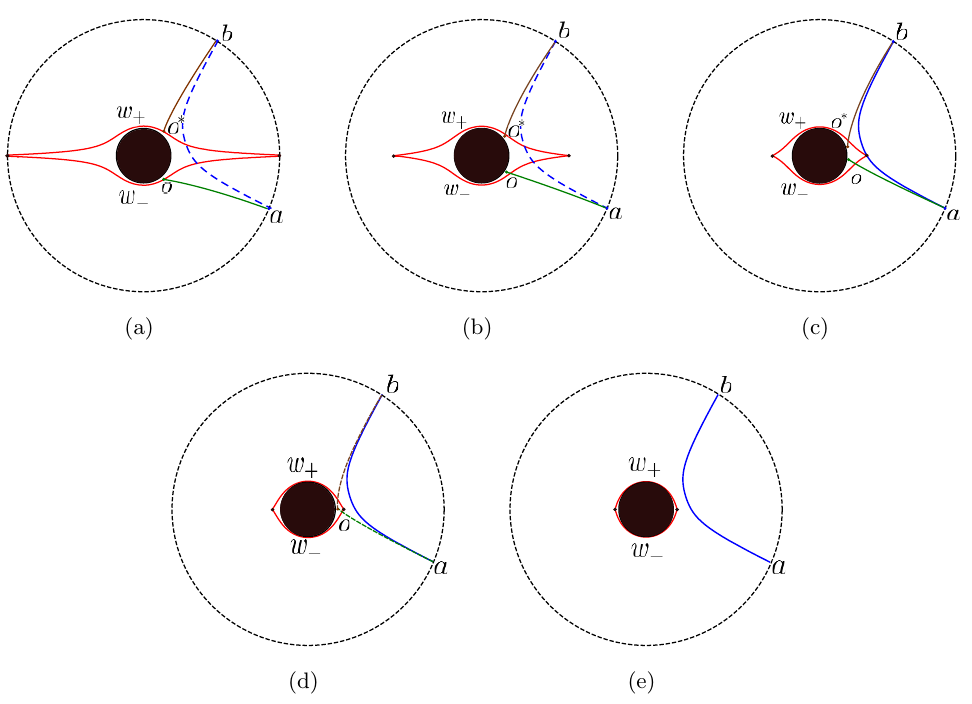
Figure 12 . Evolution of ETEBA geodesics which compete in the HRT prescription during the particle collision